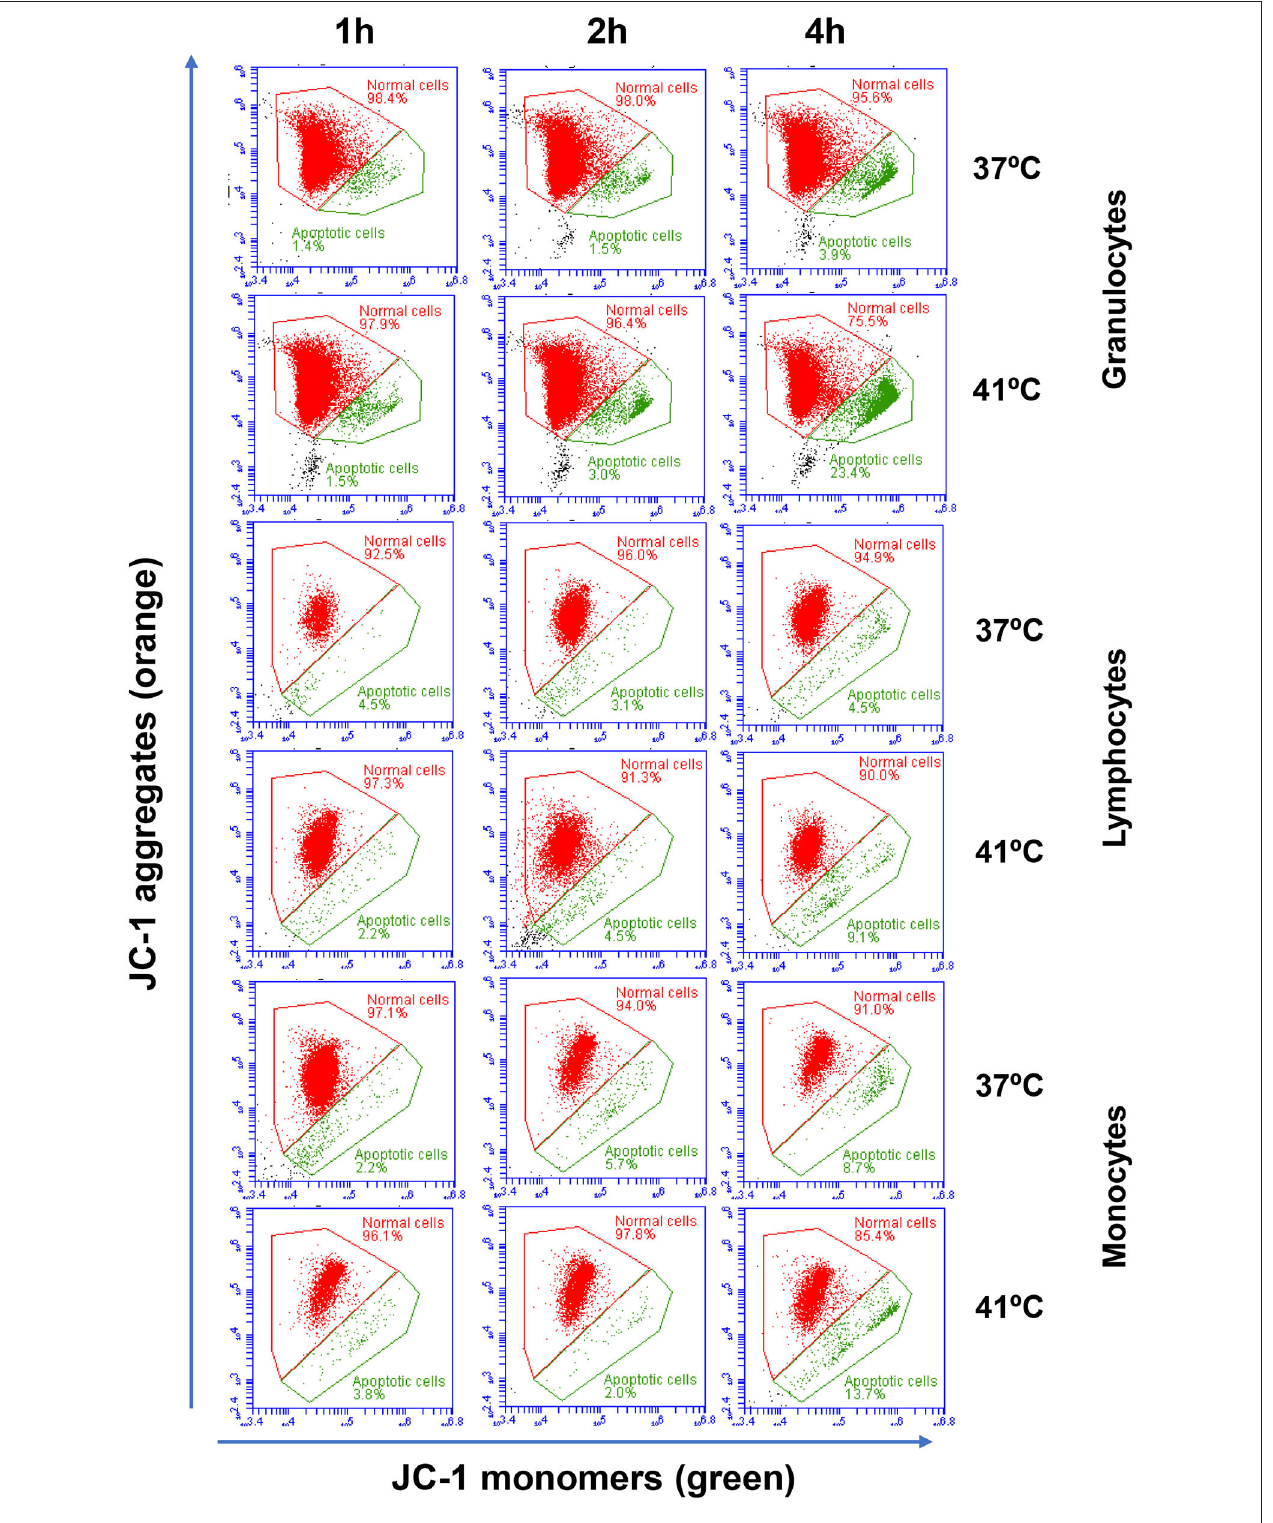
FIGURE 2 | Flow cytometric analysis of cell apoptosis. Separated blood leukocytes were loaded with the mitochondrial membrane potential (MMP) probe JC-1. After setting gates on camel granulocytes, lymphocytes, and monocytes based on their FSC and SSC characteristics and the exclusion of cell duplicates, the fractions of normal viable cells (orange JC-1 aggregates detected in FL-2) and apoptotic cells (green JC-1 monomers detected in FL-1) were calculated for blood incubated at 37 and 41 ◦ C for 1, 2, and 4h.